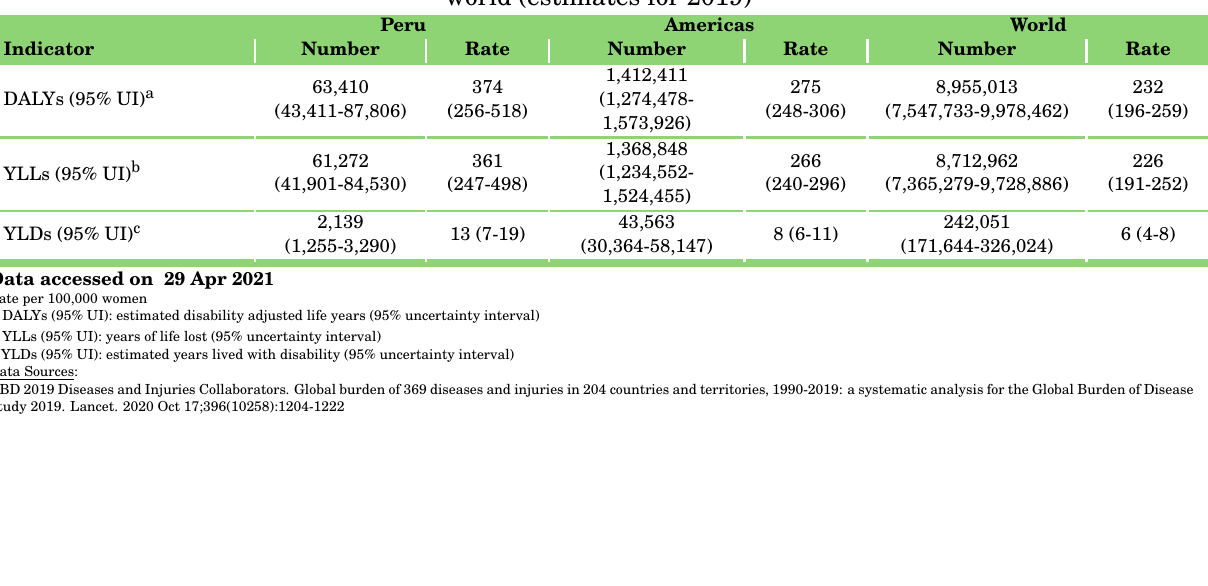
ICO/IARC HPV Information